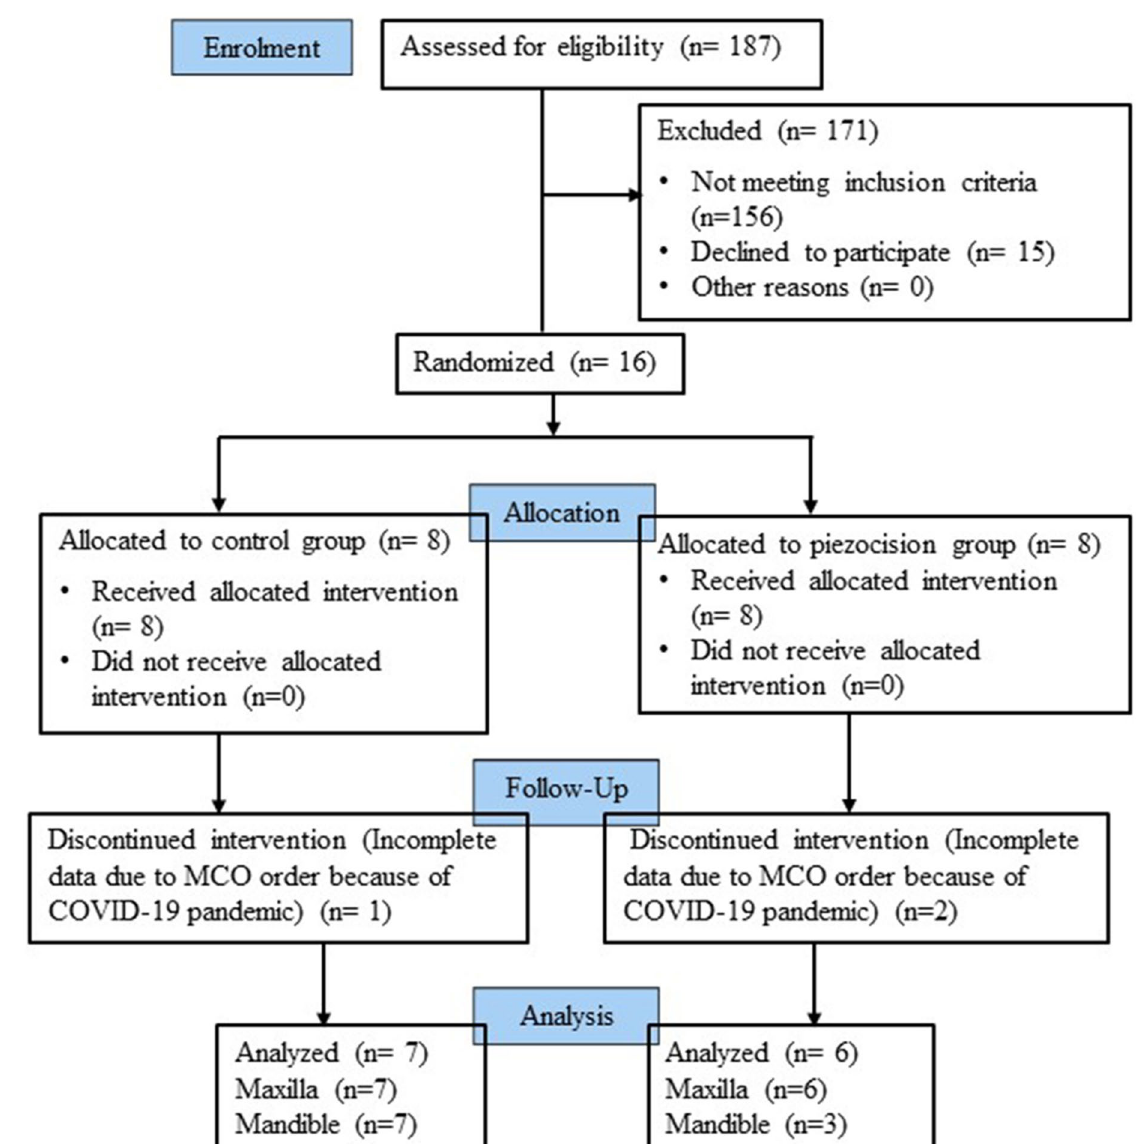
Figure 3. Consort diagram showing the overall patients flow throughout the clinical